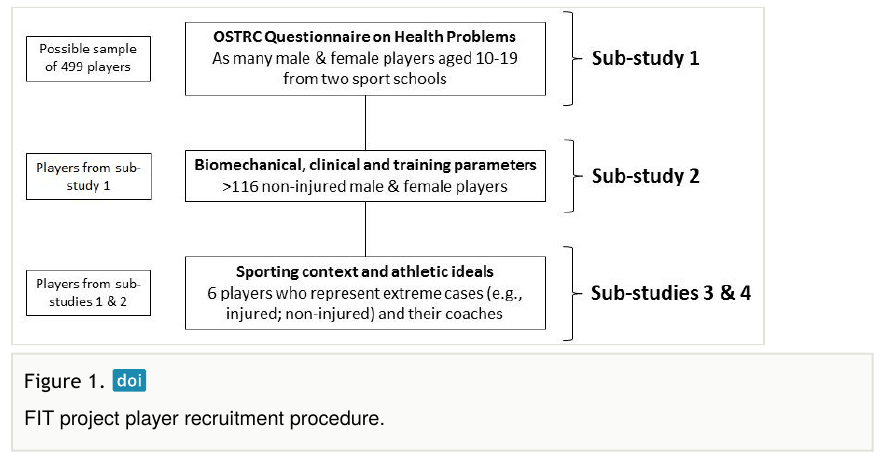
Figure 1. FIT project player recruitment